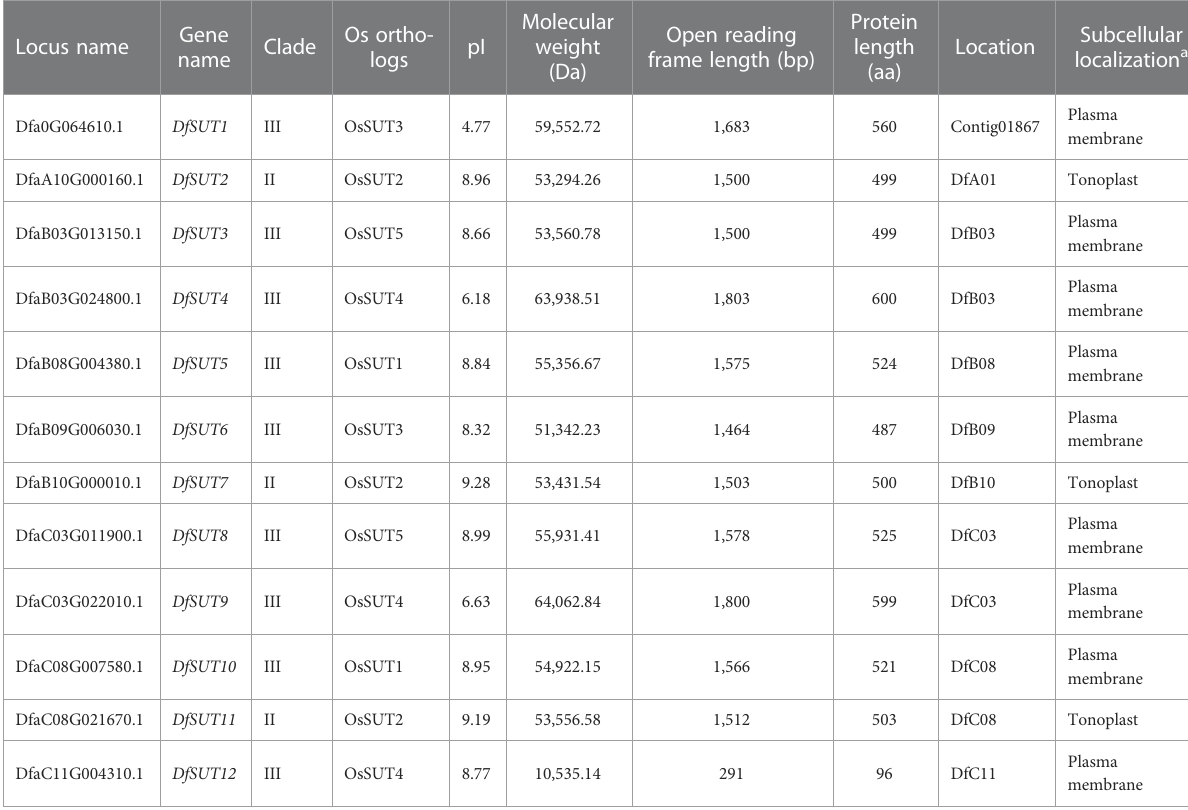
TABLE 1 Detailed information about the 12 predicted DfSUT genes in D. farinosus